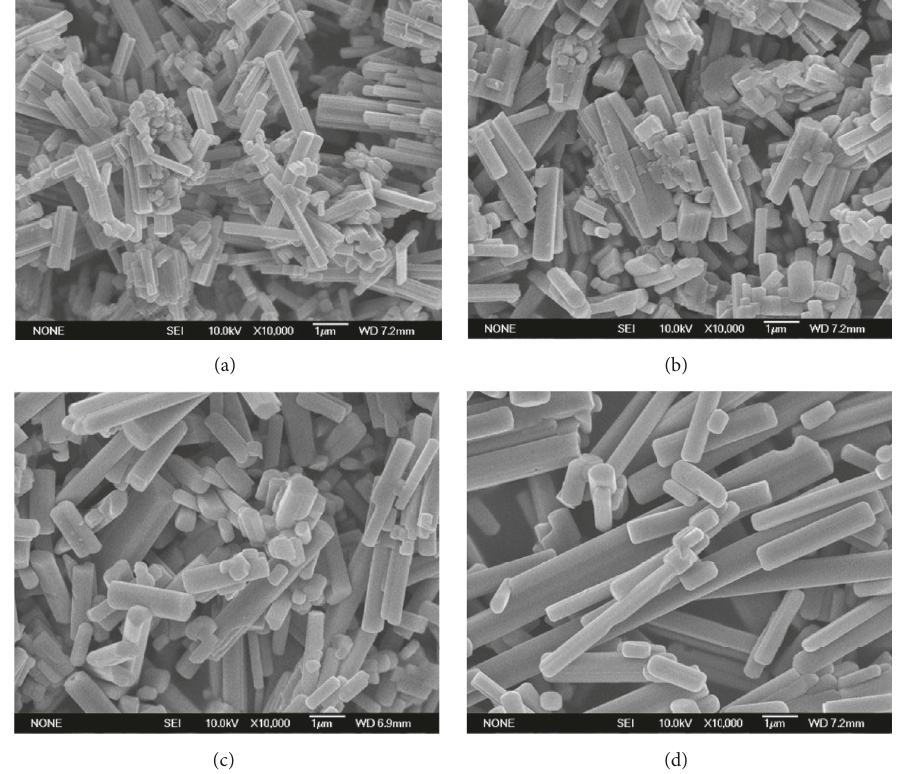
Figure 2: SEM images of the flux-synthesized SBN60 nanocrystals with flux-to-reactant weight ratio of 2 :1 at different reaction temperatures for 3 h: (a) 950 ∘ C, (b) 1000 ∘ C, (c) 1050 ∘ C, and (d) 1100 ∘ C.